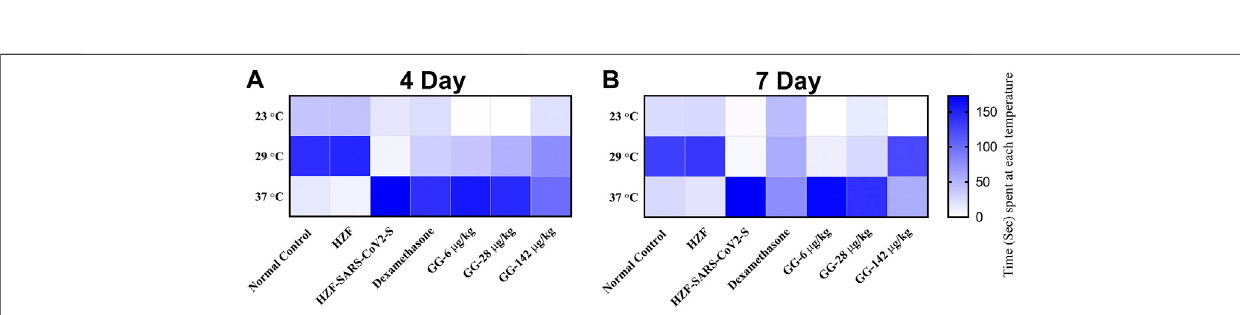
FIGURE 7 | Whole body images were captured under re fl ected light without any magni fi cation. Regions of skin hemorrhage are marked with yellow circles. (A) 4-days time point, (B) 7-days time point.